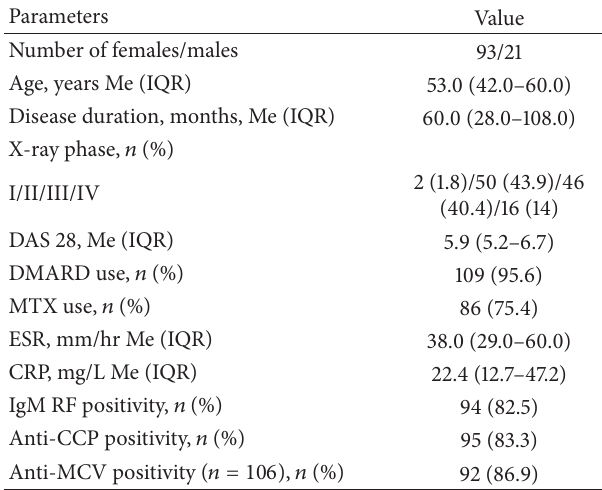
Table 1: Demographic, clinical, and laboratory data for the group of RA patients ( 𝑛 = 114